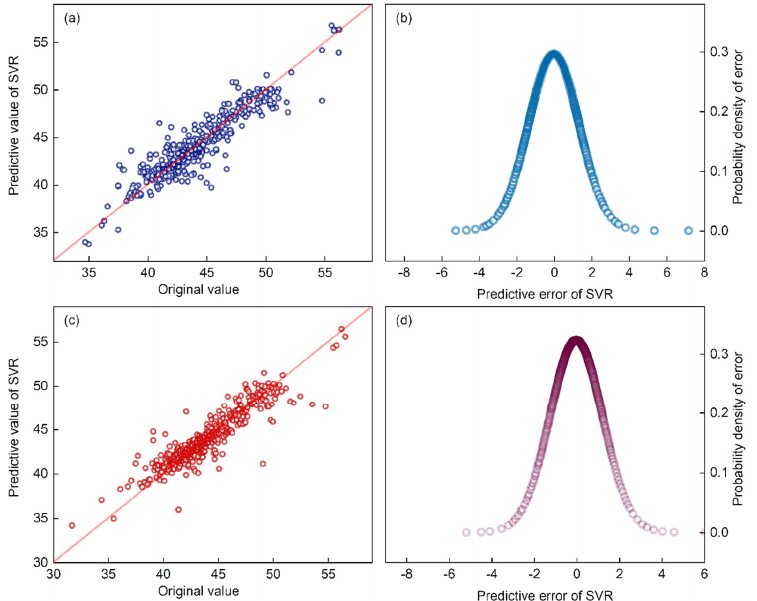
Figure 9. The comparison of the predicted errors of the SVR model (the forecasting parameter is the GUR-2h). Prediction bias ( a ) and probability density of prediction errors ( b ) for the SVR model based on the BDS. Prediction bias ( c ) and probability density of prediction errors ( d ) for the SVR model based on the NDS. Compared to Figure 9c, the data in Figure 9a fluctuate slightly. In Figure 9b,d, the range of prediction errors gradually expands. When the output parameter is the GUR-3h,